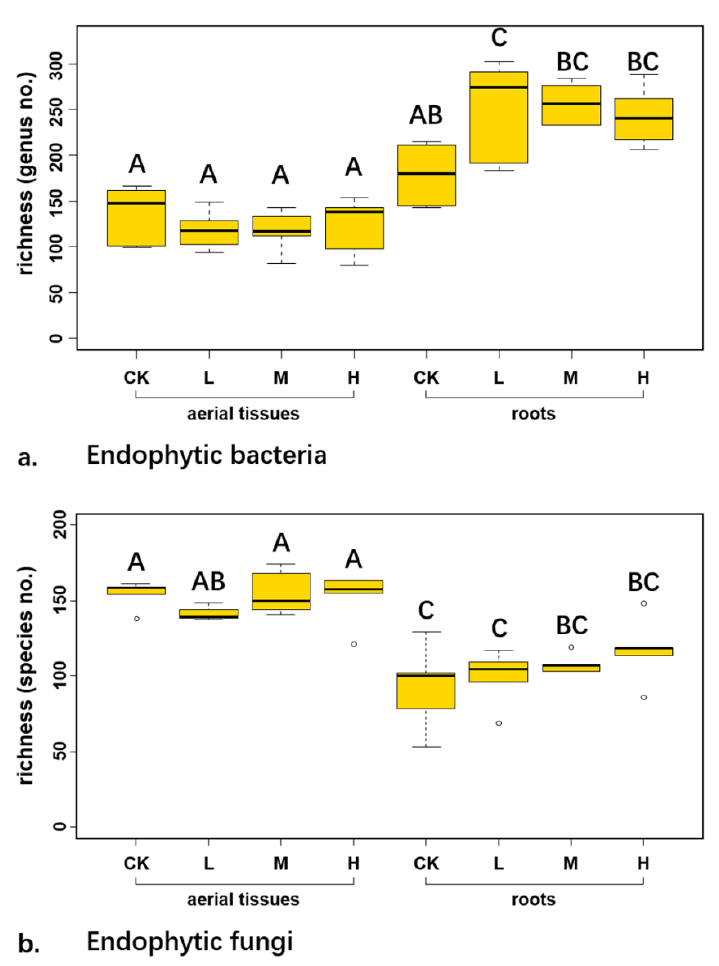
Figure 2. The genus richness of endophytic bacterial ( a ) and species richness of endophytic fungal ( b ) communities in each treatment. C, L, M, and H in x-axis represented control, low, medium, and high level ionizing radiation treatments, respectively. Capitalized letters showed significance at p = 0.05 level in HSD